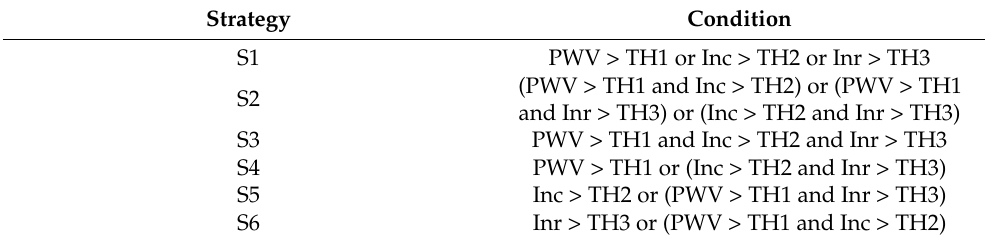
Table 6. Six strategies formed by satisfying different conditions from the three prediction factors.